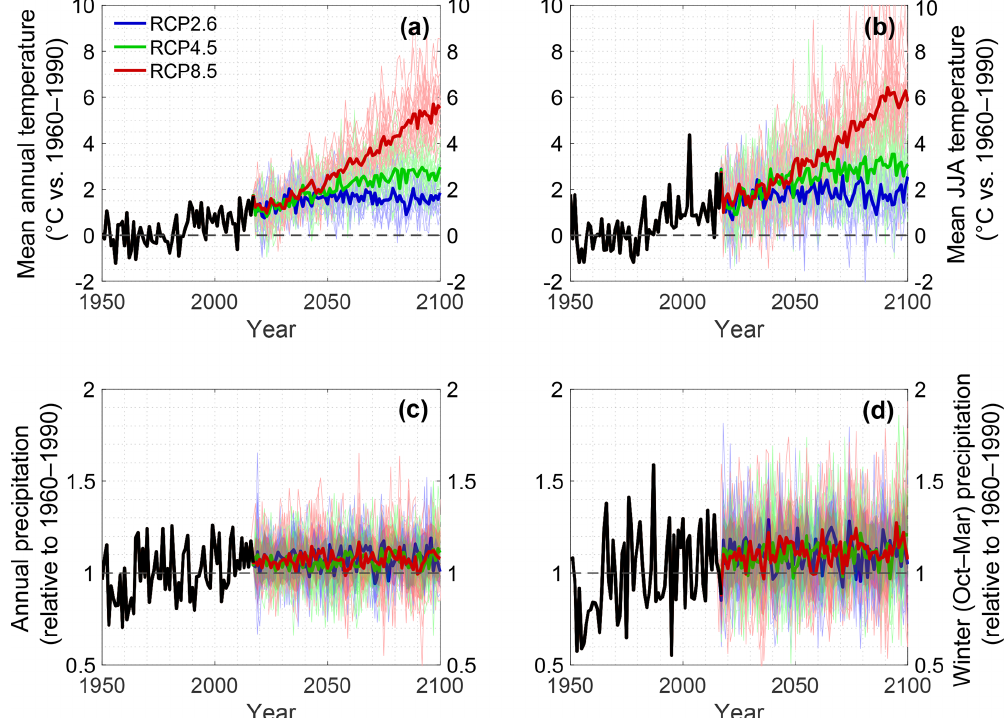
Figure 2. Debiased temperature anomaly ( a : annual b : June–July–August) and debiased precipitation anomaly ( c : annual and d : October– March) between 1950 and 2100 relative to 1961–1990 (horizontal dotted line). All values correspond to the mean over all grid cells used in this study, weighed by the glacier area (at inventory date) in every cell. The thick black line represents the evolution of the variables for observational period (E-OBS dataset). The coloured thin lines represent the evolution for individual RCM simulations from the EURO- CORDEX ensemble (51 in total; see Table S1), and the thick lines are the RCM simulation means (one per